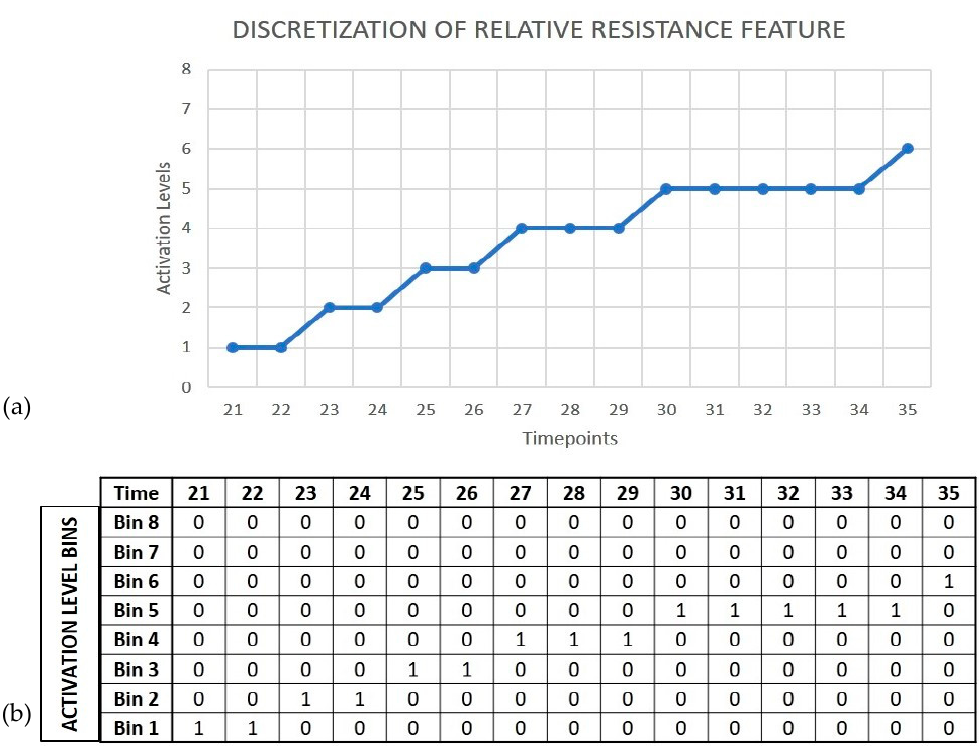
Figure 6. A snapshot of the discretization process. ( a ) The graph shows an 8-level discretization of the normalized relative resistance change features for sensor 11 when exposed to 2-hexenol for 15 timepoints. ( b ) One-hot encoded binning based on partitions of the activation levels.